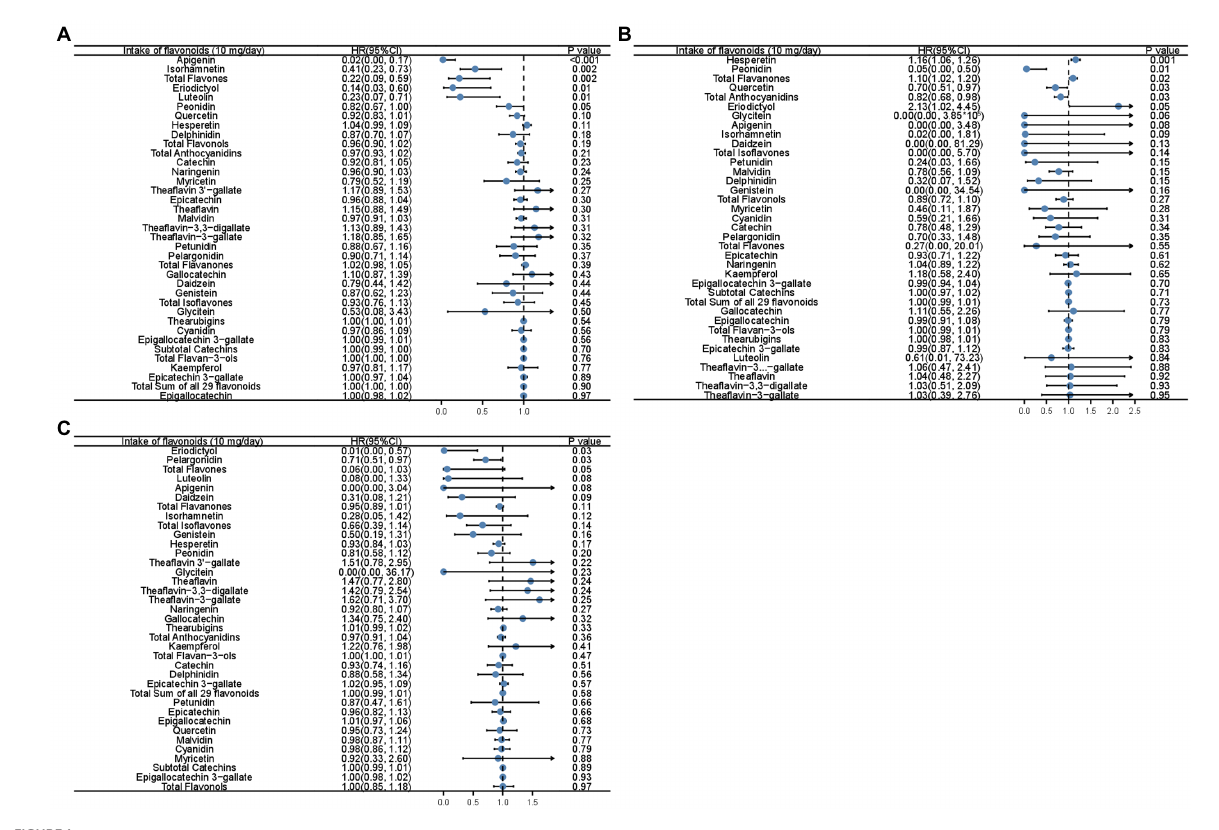
FIGURE 1 Forest plots showing the association between flavonoid intake and all-cause mortality (A) , mortality of heart diseases (B) , and mortality of cerebrovascular diseases (C) in Cox analysis adjusted for age and PIR with the increment unit of 10 mg/day. HR: Hazard ratios; PIR: poverty income